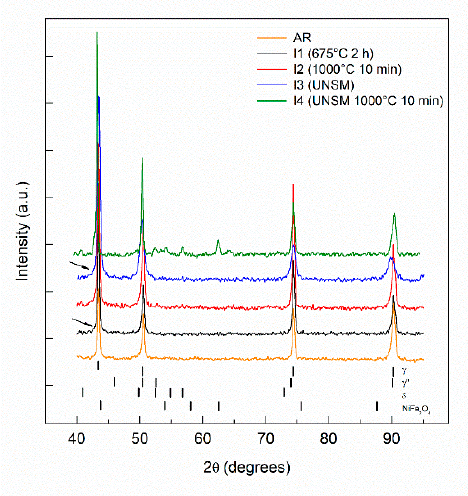
Figure 10. XRD (X-ray diffraction) patterns for Inconel 718 samples with different thermal and/or UNSM treatments.